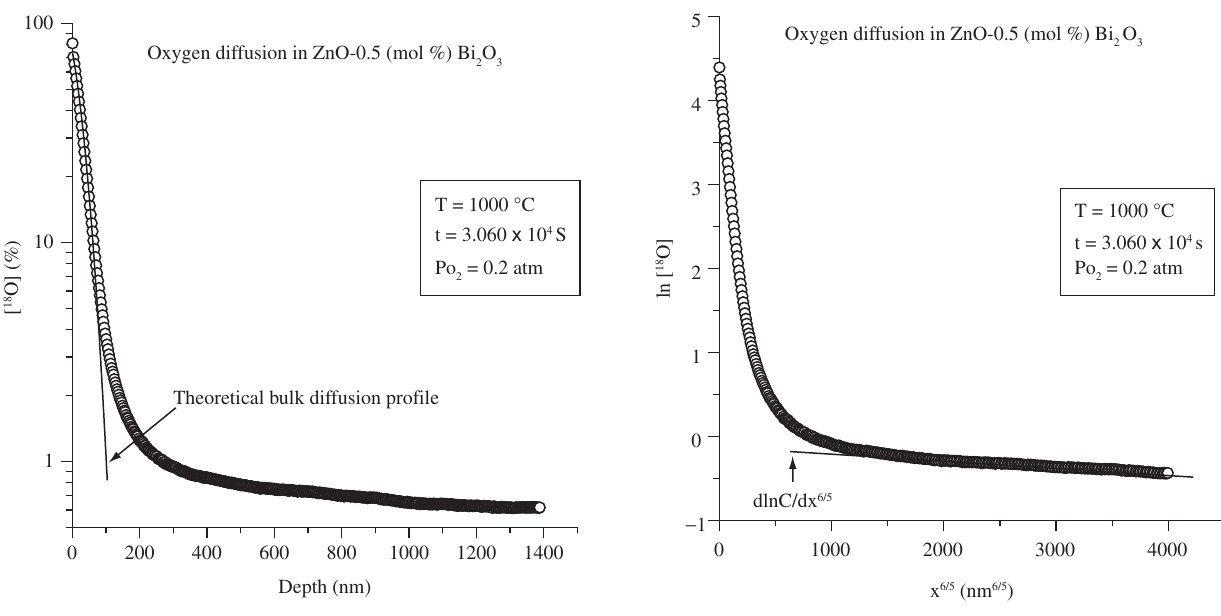
Table 1. Oxygen diffusion in Bi